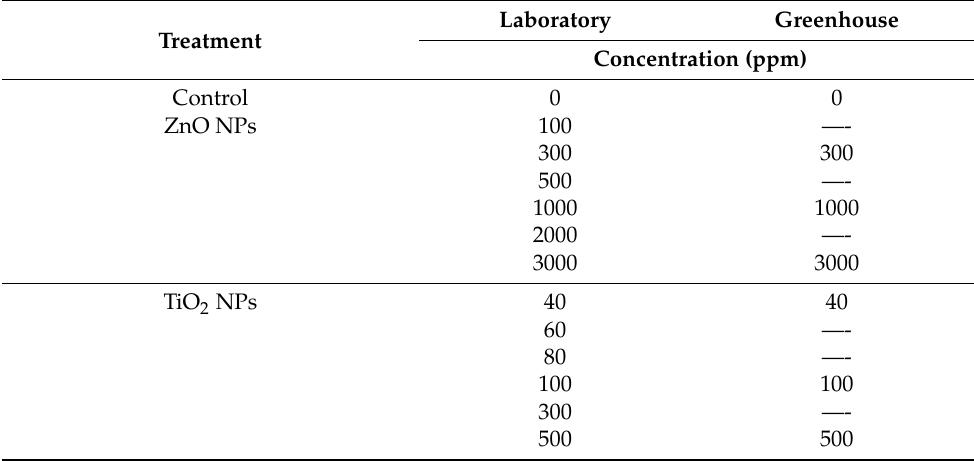
Table 1. Nanoparticles concentrations evaluated for Bactericera cockerelli control in the laboratory and